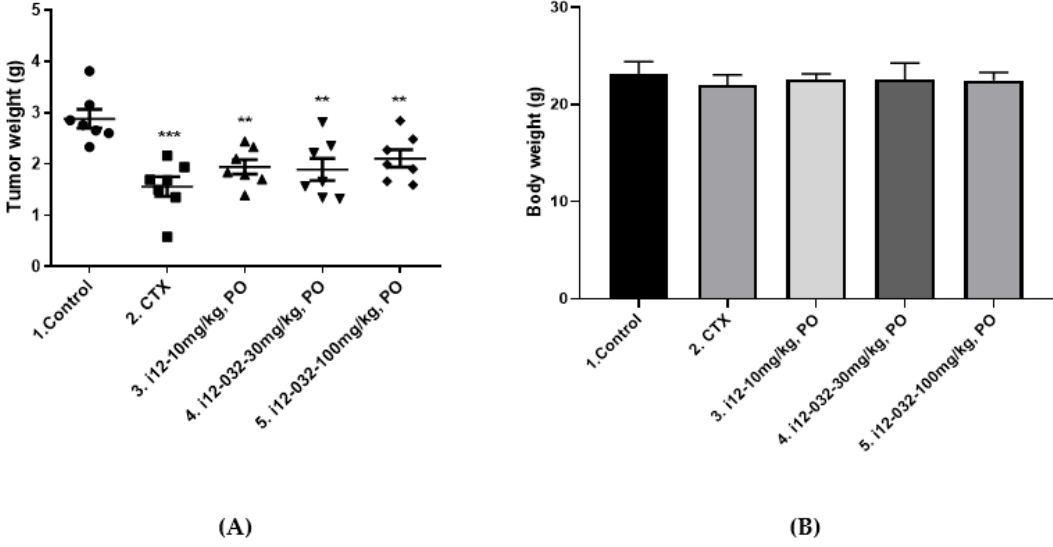
Figure 5. In vivo anti-tumor activity of i12 in PAN02 pancreatic cancer xenograft mice. ( A ) Tumor weights of each group after 15 days of treatment. The control group mice bearing PAN02 pancreatic cancer xenografts were dosed orally with vehicle (0.5% sodium salt of carboxymethyl cellulose, CMC-Na); the CTX group were administered CTX intraperitoneally at the dose of 60 mg / kg; the treated group were administered i12 orally at the dose of 10, 30 or 100 mg / kg. ** p < 0.01 and *** p < 0.001 versus vehicle. ( B ) The body weight of each group after the treatment. There is no obvious body weight difference among any of the i12 -treated groups.